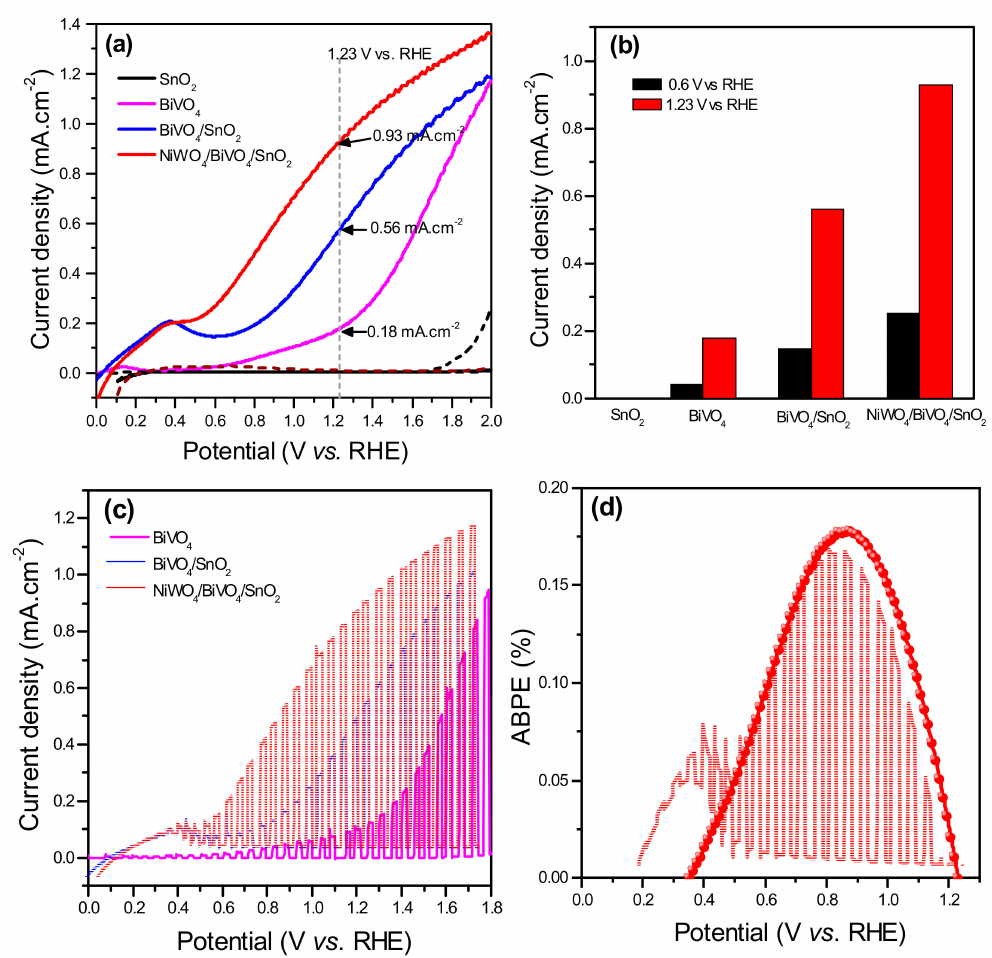
Figure 5. Photoelectrochemical properties of photoanodes. ( a ) Photocurrent-potential characteristics for bare-BiVO 4 , BiVO 4 / SnO 2 , and NiWO 4 / BiVO 4 / SnO 2 photoanodes evaluated in PBS solution (0.1 M, pH 7.5) at AM 1.5G condition (sweep rate = 10 mV / s). ( b ) Changes in photocurrent